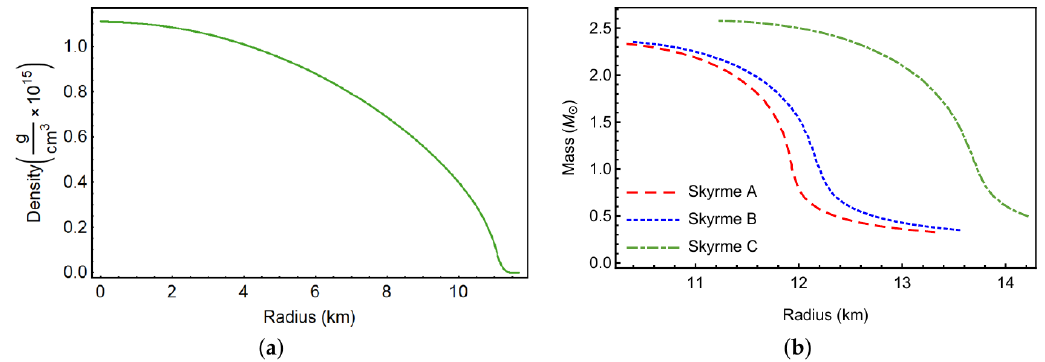
Figure 2. ( a ): Density profile vs. radius of the Skyrme (Model A) equation of state, with a central density of 1.102 × 10 15 g/cm 3 , corresponding to a mass of 1.69 M (cid:12) and radius of 11.68 km. The density decrease is not smooth near the surface of the star. This feature requires special care in the solution of the oscillation equations. ( b ): Mass-radius curves for the Skyrme A, B, and C models. All three models can support a maximum mass of more than 2 M (cid:12)